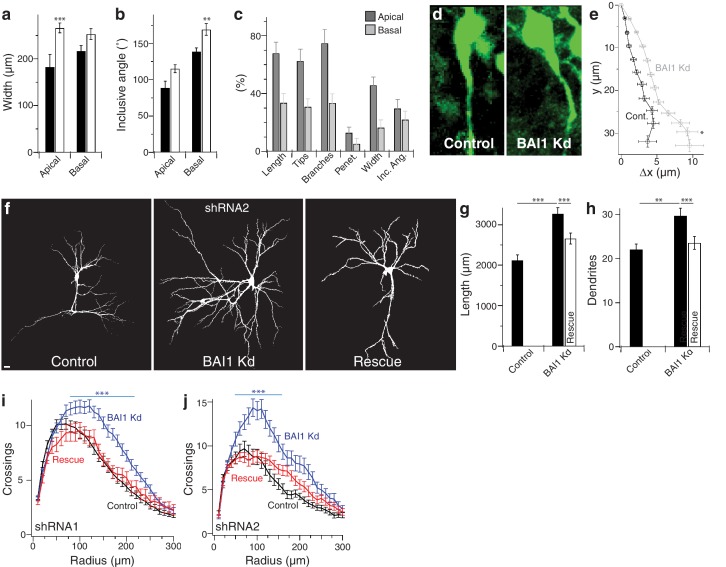
BAI1 restricts dendrite growth in developing hippocampus.(a) Summary data of the maximal lateral width of dendritic arbors. (b) Summary data of minimum angle centered on the cell body that includes the entire indicated dendritic domain. (c) % change in each of the indicated parameters for apical and basal dendrites. Note that the apical dendrites are more affected than basal dendrites by BAI1 Kd. (d) Representative images of neurons aligned so that the hippocampal cell layer was parallel to the page. (e) Summary data of the position of the primary apical dendrite. Total number of neurons: 19 for control neurons (N = 3) and 38 for BAI1 Kd neurons (N = 4). (f) Representative images of hippocampal neurons expressing EGFP and empty vectors (control), shRNA against Adgrb1 (BAI1 Kd) or shRNA against BAI1 and RNAi-resistant BAI1 (Rescue) fixed at 21 DIV. Images are masked to remove all axons and dendrites from other neurons. (g) Summary data for dendrite length. (h) Summary data for dendrite number. (i) Summary data for Sholl crossings with shRNA1. (j) Summary data for Sholl crossings with shRNA2. Total number of neurons for shRNA1 experiments: 118 for control neurons, 106 for BAI1 Kd neurons, and 65 for rescue neurons (N = 7). Total number of neurons for shRNA2 experiments: 39 for control neurons, 34 for BAI1 Kd neurons, and 35 rescue neurons (N = 4). Data are represented ± s.e.m. (***p<0.0001, **p<0.01, *p<0.05) Detailed statistics are found in Figure 1—figure supplement 2—source data 1.10.7554/eLife.47566.006Figure 1—figure supplement 2—source data 1.Statistical summary for Figure 1—figure supplement 2: ANOVA and key Tukey post-hoc tests and N and n values for Figure 1—figure supplement 2a,b,e,g–j.